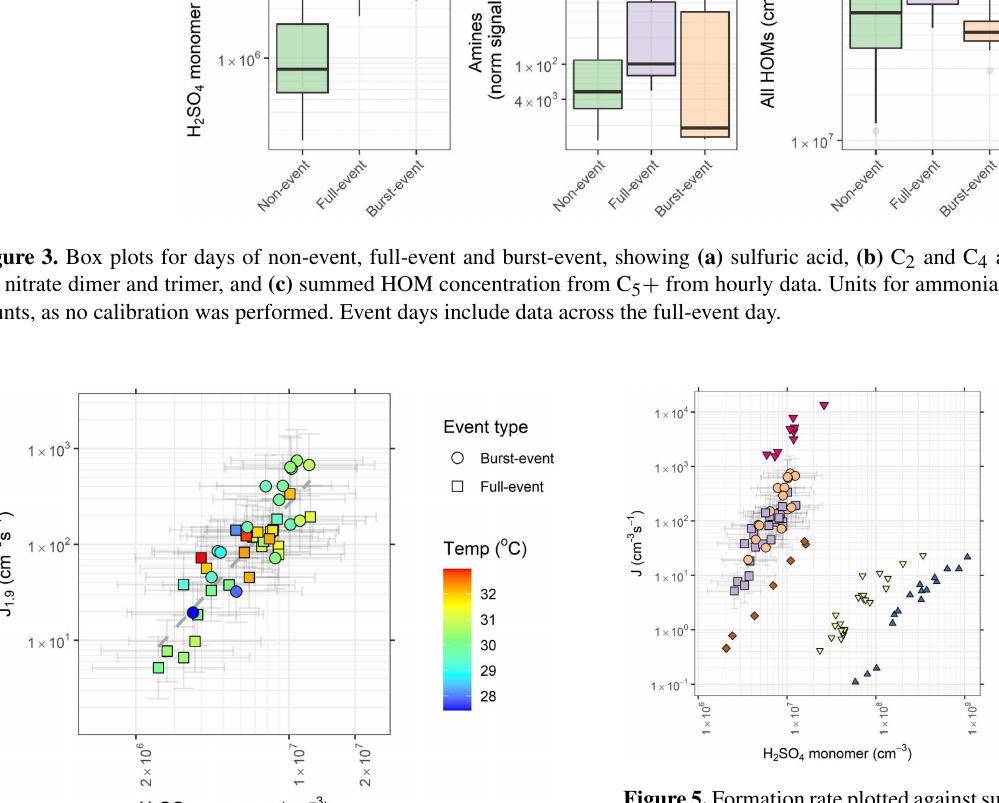
Figure 5. Formation rate plotted against sulfuric acid monomer con- centration for data collected from Barcelona. Tan circles represent burst events and purple squares represent full events, as well as that for the H 2 SO 4 –H 2 O (blue inverted triangles), H 2 SO 4 –NH 3 –H 2 O (yellow inverted triangles), H 2 SO 4 –DMA–H 2 O (pink triangles), and H 2 SO 4 –BioOxOrg–H 2 O (brown diamonds) systems from the CLOUD chamber (Kürten et al., 2018; Kirkby et al., 2011; Ric- cobono et al., 2014). CLOUD chamber experiments were performed at 278K and 38%–39% relative humidity (RH). Data are for hourly averages across NPF periods, typically within the hours 08:00– 16:00. Error bars represent systematic uncertainties in [H 2 SO 4 ] and J 1 . 9